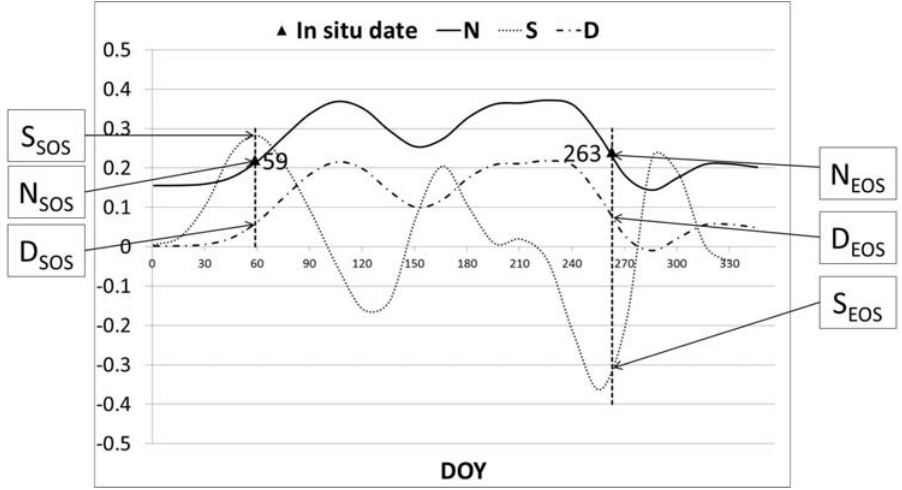
Figure 4. Deriving values for NDVI (N), Slope (S), and Difference (D) for each agro-meteorological station based on the observed start of the growing season (SOS) or end of the growing season